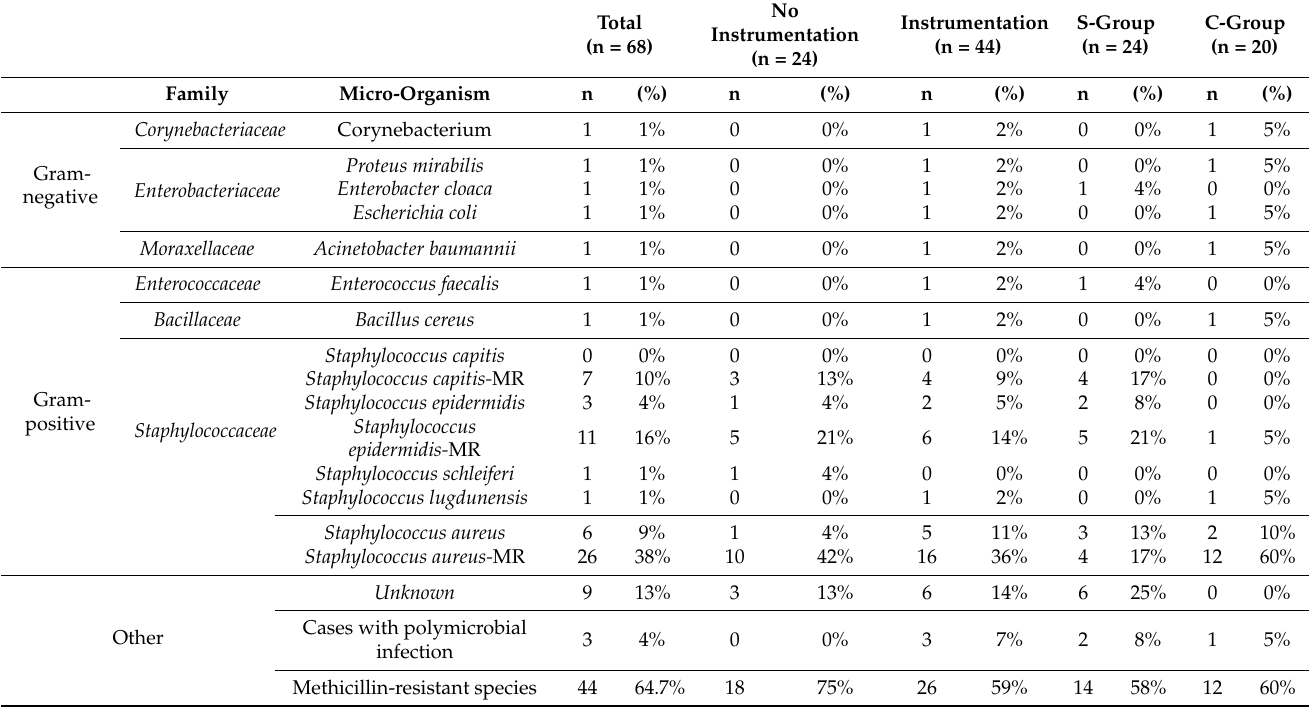
Table 1. Culture results determining the bacterium causing post-spinal surgery deep incisional SSI, comparing between instrumented and non-instrumented spinal surgeries and the S-group to the C-group. The (%) represents the percentage of patients scoring positive for a particular microbe. MR: